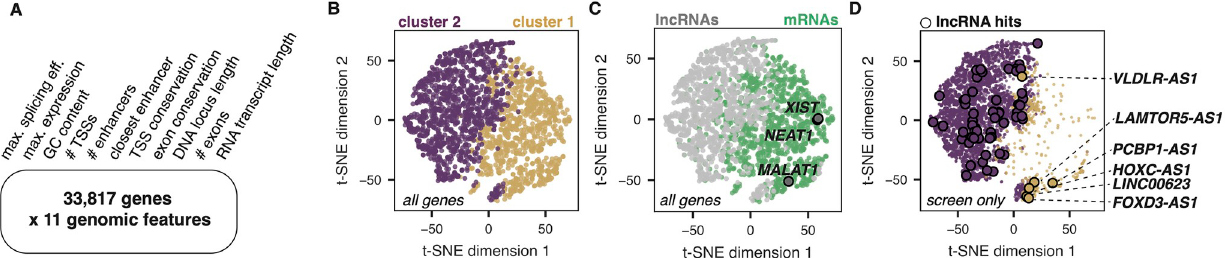
Fig 6. Using k-means clustering of 11 genomic features to find candidate functional RNA molecules. (A) List of the 11 genomic features used in clustering analysis across 33,817 genes. (B) t-SNE visualization of the data matrix outlined in (A), colored by k-means cluster assignment. Plot shows a sub- sample of the data: 1000 randomly-sampled lncRNAs and 1000 randomly-sampled mRNAs. (C) Same t-SNE as in (A), now colored by biotype, where gray dots are lncRNAs and green dots are mRNAs. The 3 “gold standard” lncRNAs ( XIST , NEAT1 , and MALAT1 ) are highlighted and outlined in black. (D) Subset of the same t-SNE in (A) and (B), now showing only lncRNAs included in the screen, colored by their cluster assignment. Significant hits in either cluster are outlined in black. Hits assigned to cluster 1 are annotated.